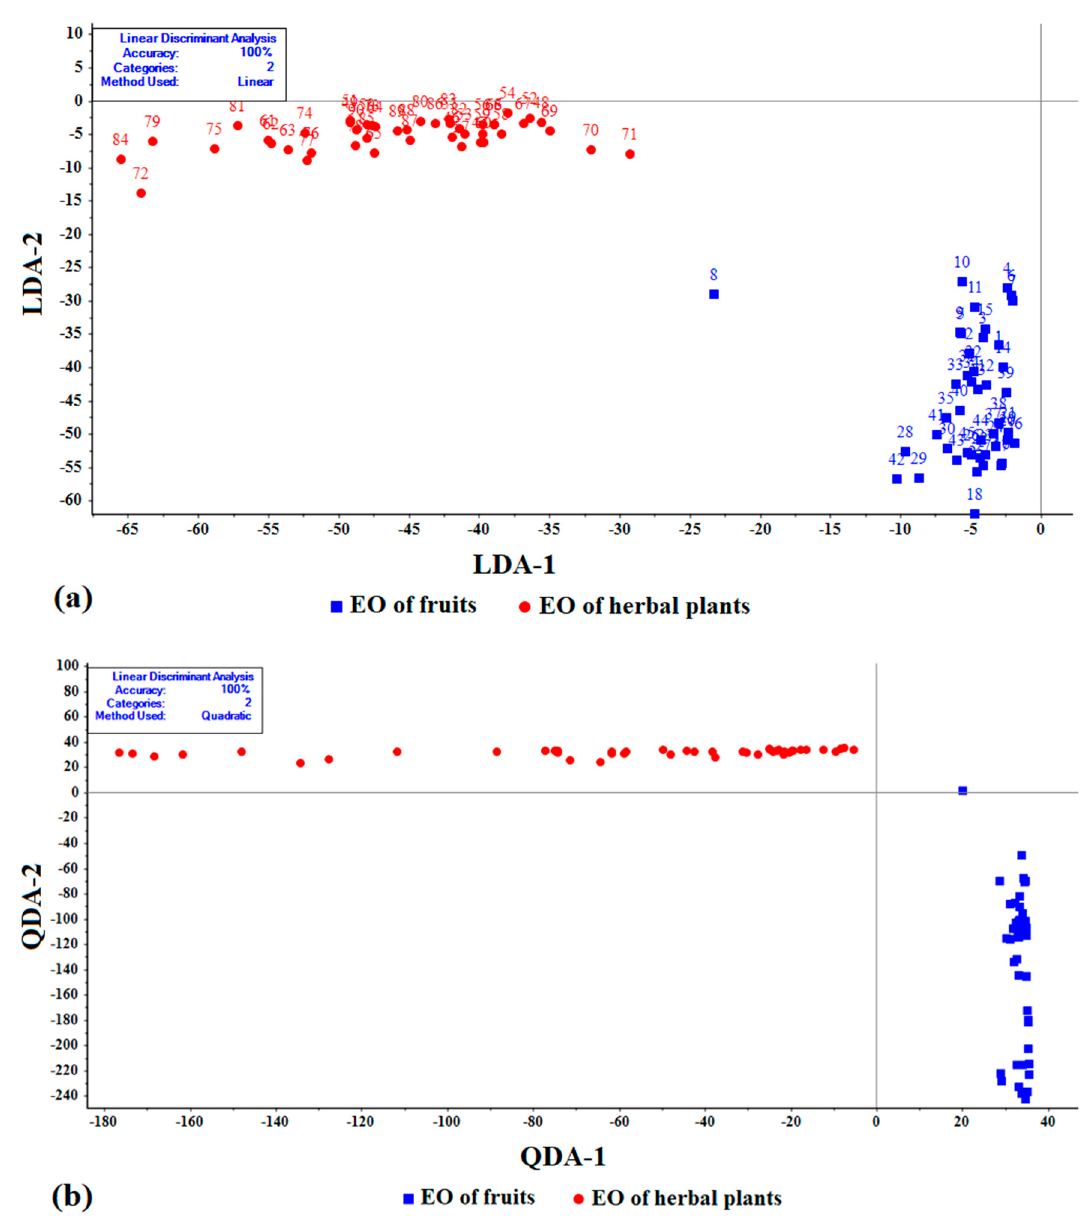
Figure 5. Classification of essential oils from edible plants. Comparison of methods: ( a ) LDA and ( b ) QDA methods.